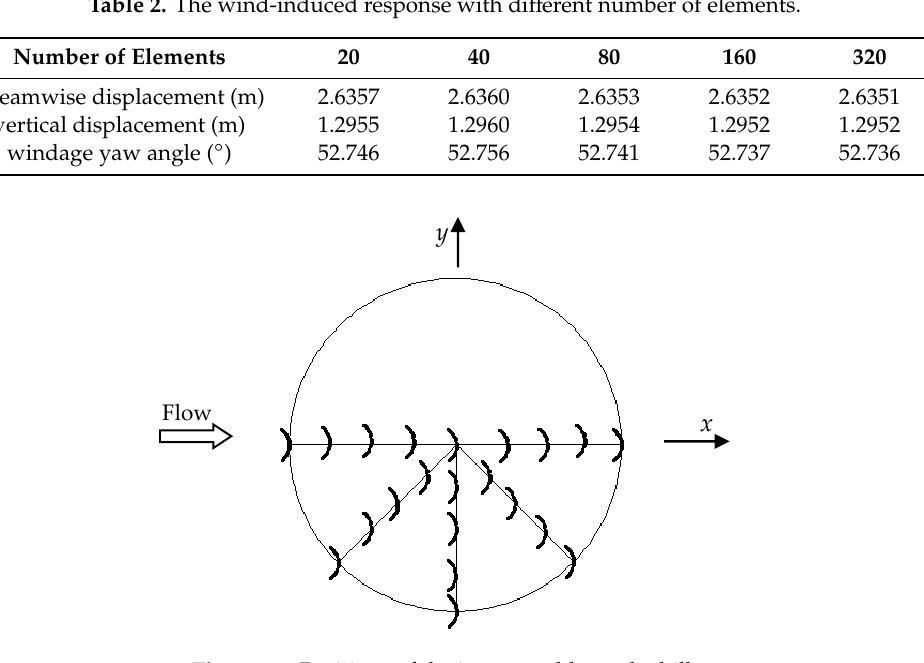
Figure 18. Positions of the jumper cable on the